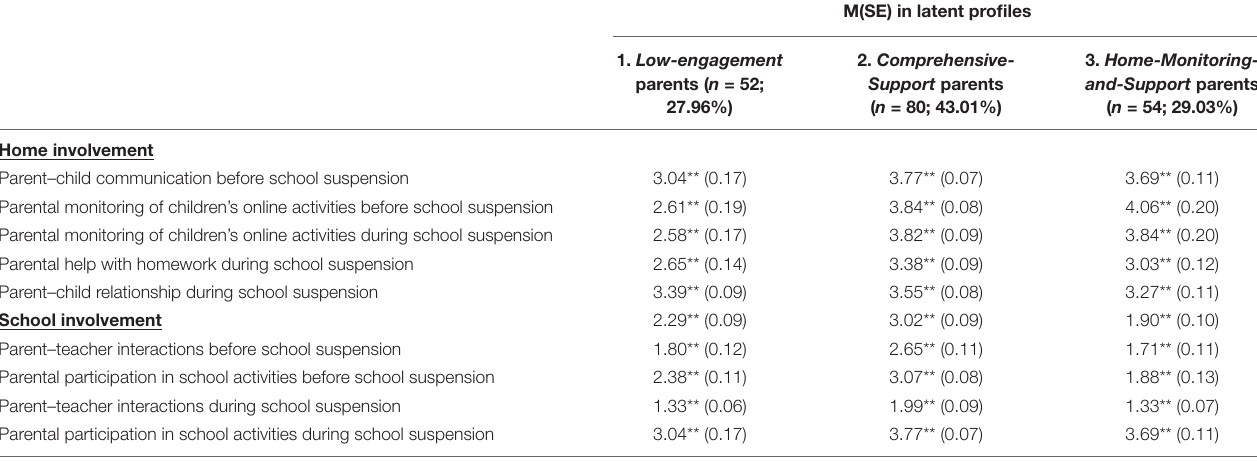
TABLE 6 | Descriptives for parenting variables (primary